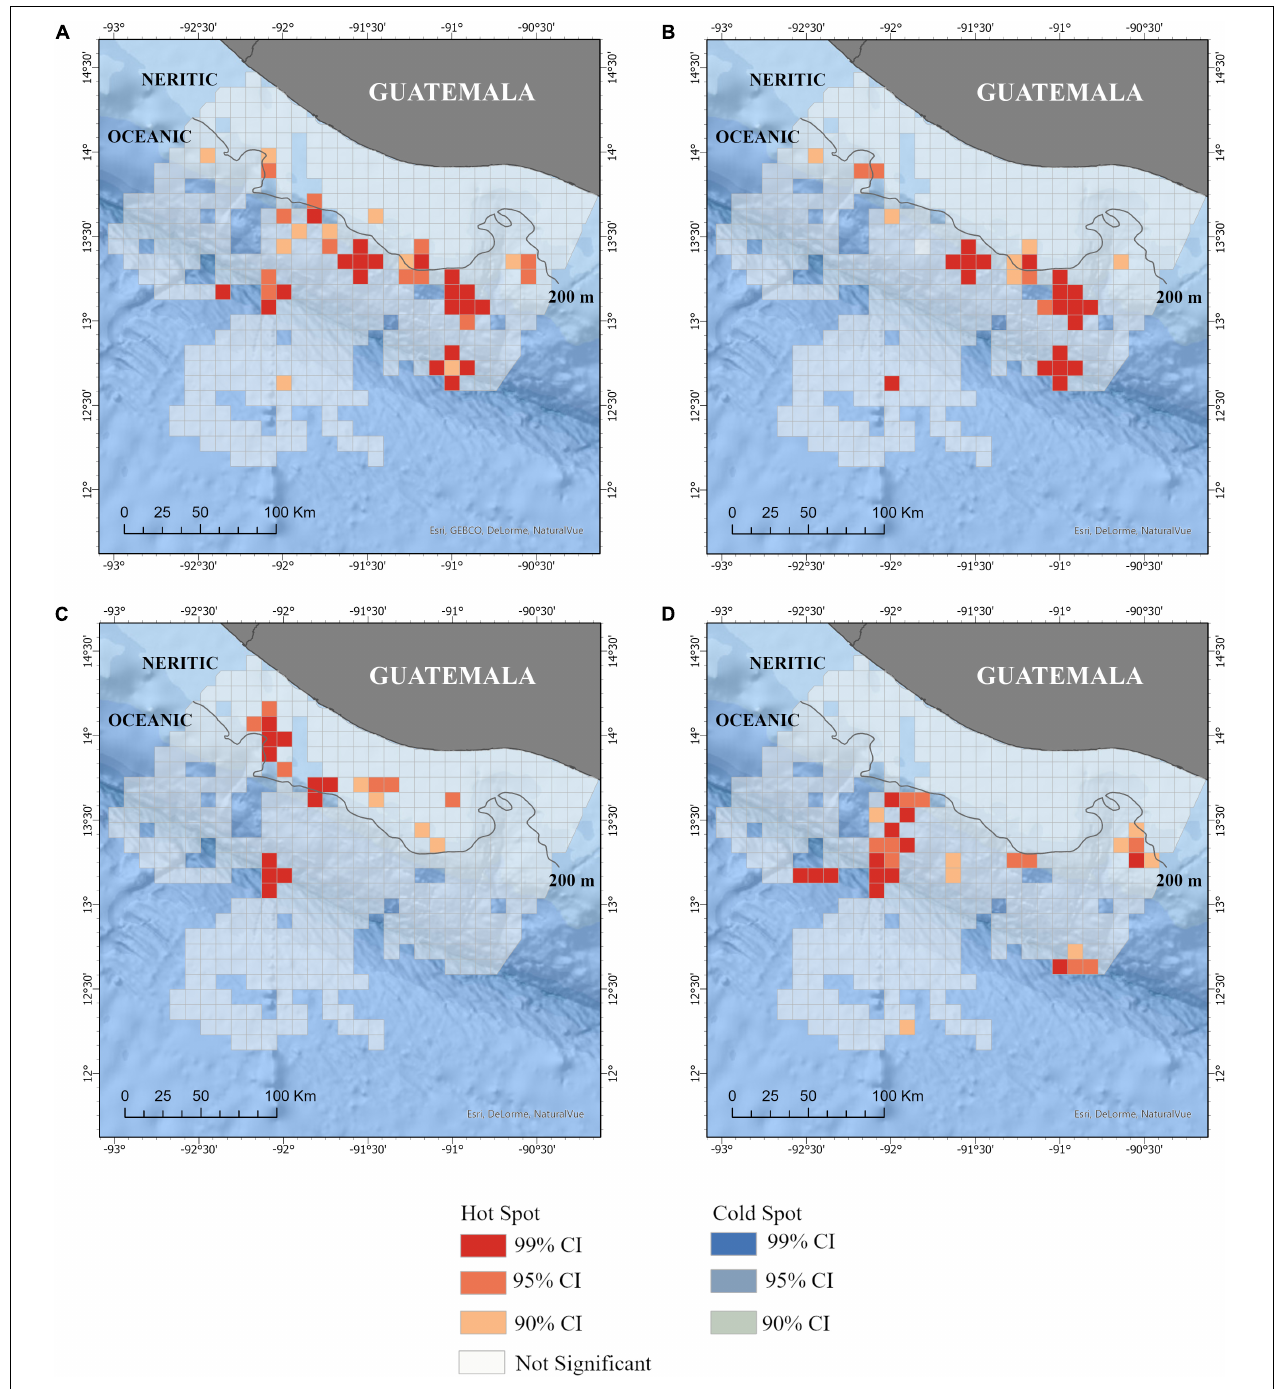
FIGURE 6 | Hot spots of sightings of all cetacean species (A) and the three most common species: (B) Tursiops truncatus , (C) Stenella attenuata , and (D) Stenella longirostris in the Pacific waters of Guatemala. No cold spots were identified. Neritic ( < 200 m depth) and ocean ( > 200 m depth) zones are also included. Additional details of the study area are shown in Figure 1